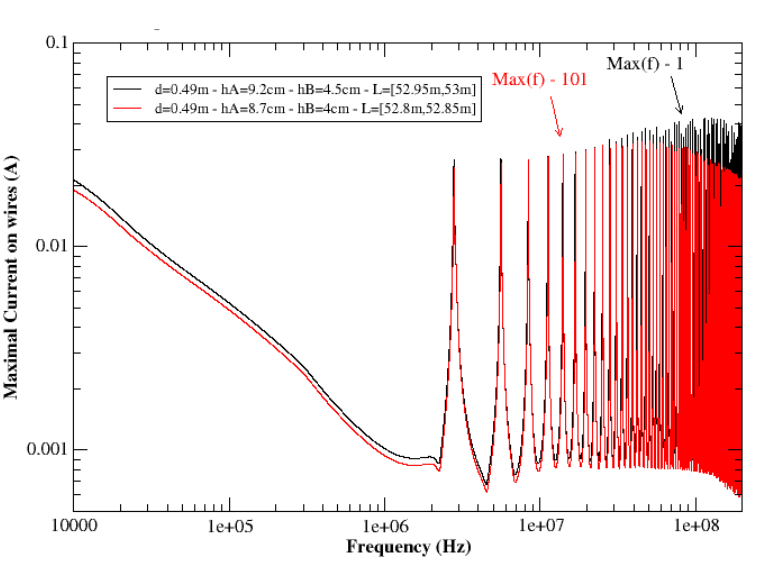
Figure 4. Examples of currents induced on bundle B